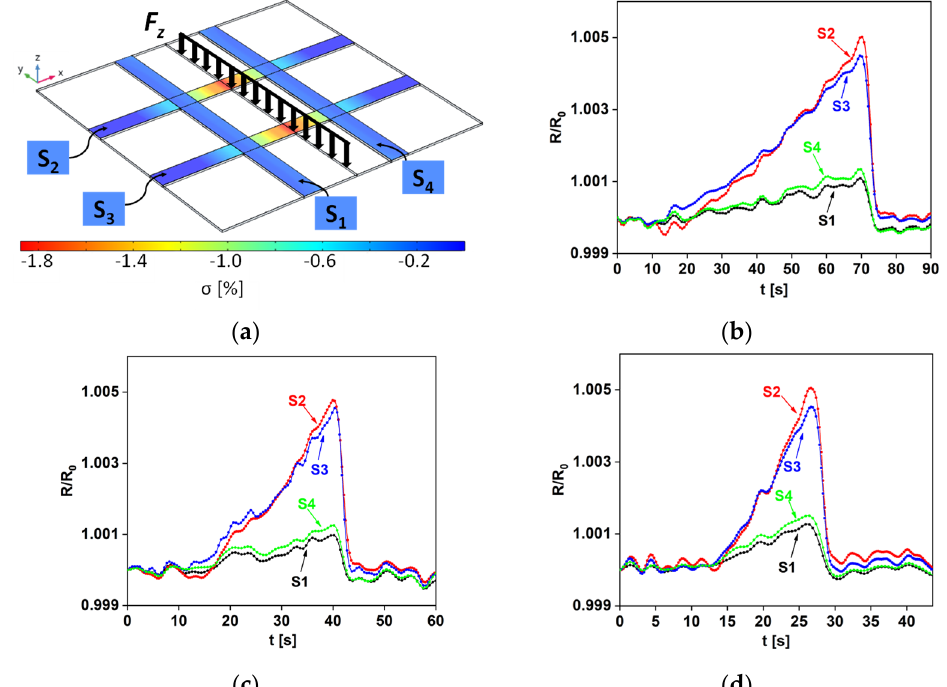
Figure 13. ( a ) Schematic representation of the distributed load applied to the sample with the sensor array and conductivity map of the piezoresistive strips at the maximum induced plate deformation; normalized resistance variation of the four sensors over time at ( b ) 5 mm/min, ( c ) 10 mm/min, and ( d ) 20 mm/min crosshead speed.